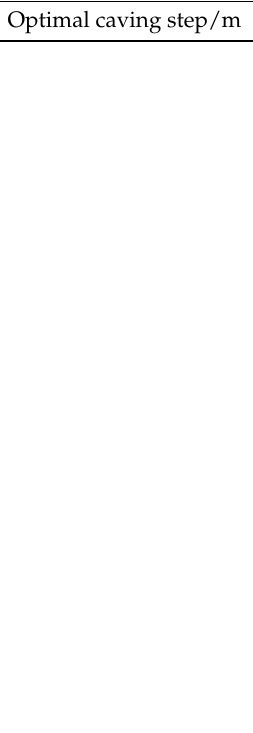
Table 7. Various methods are used to obtain the optimal step range. Bottom